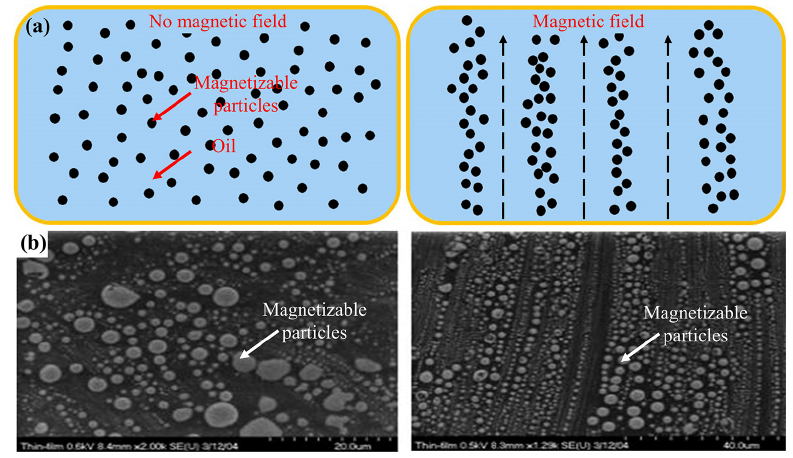
Figure 4. ( a ) Microstructure diagram of MRF. ( b ) Scanning electron microscopy photos of MRE microstructure variation.